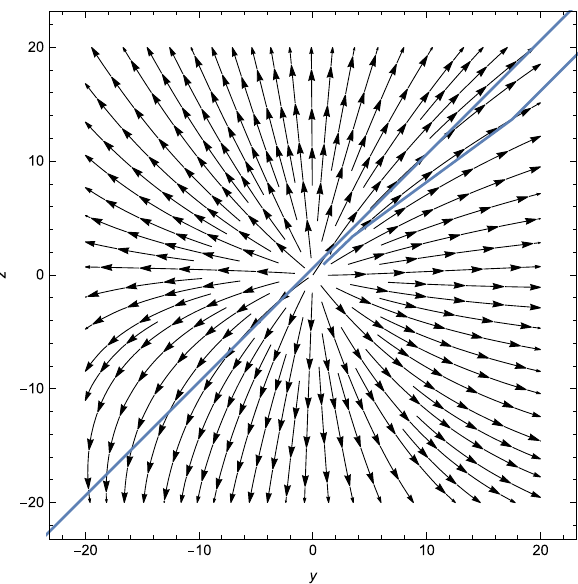
Fig. 10 Thephaseplotofunstablerepeller ( 0 , 0 ) foranalysingstability at infinity for case I when γ = 0, α 2 > 3 taking C o = 8 π G = 1